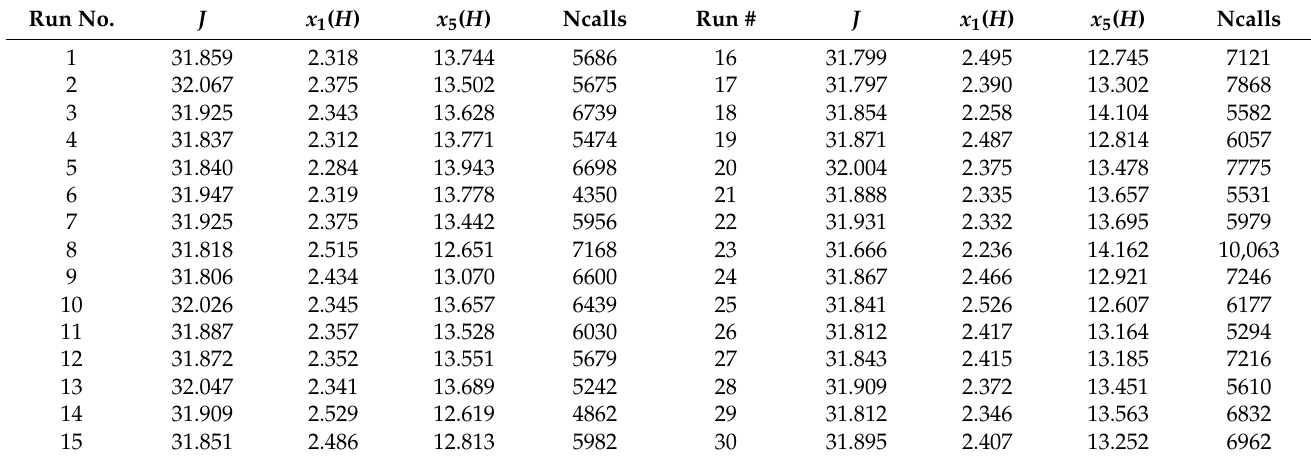
Table 3. Results of the simulation series for RHC_EA with control input range estimation. Run